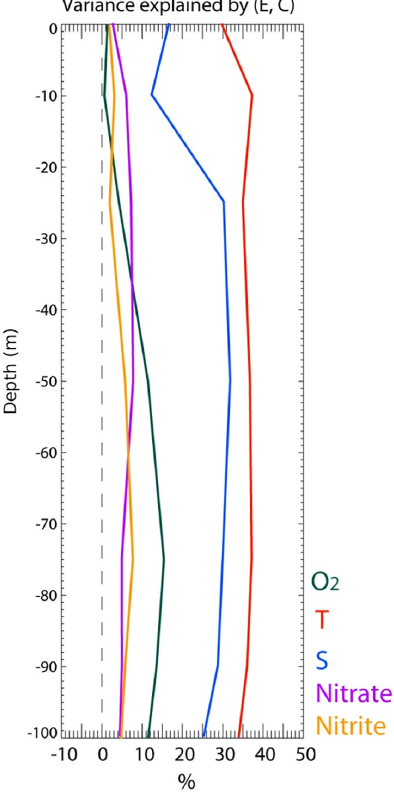
Figure 7. Percentage of variance explained by the projection of the data on the E and C modes as a function of depth for temperature (red), salinity (blue), oxygen (dark green), nitrate (purple) and ni- trite